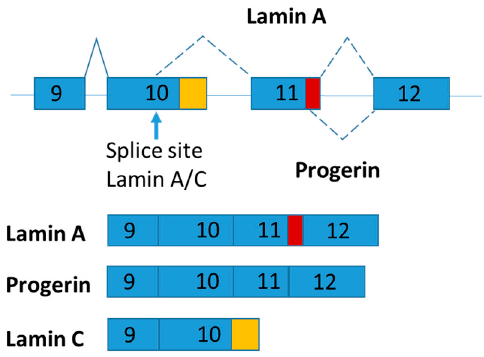
Figure 4. Schematic figure representing LMNA splice variants. The part of exon 11 specific for lamin A is marked in red and the part of 10 specific for lamin C is marked in orange.